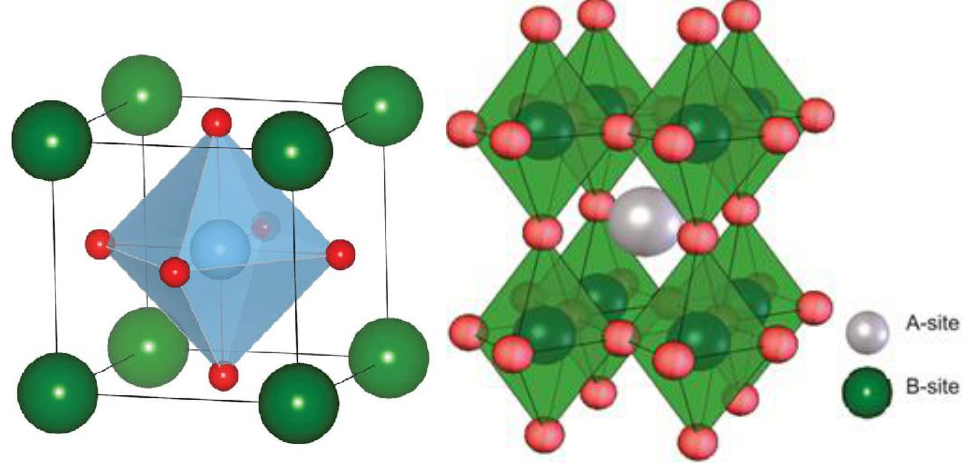
Figure 1. Perovskites ABO 3 with similar sizes of A-site and B-site cations; red circles comprise ani- ons.